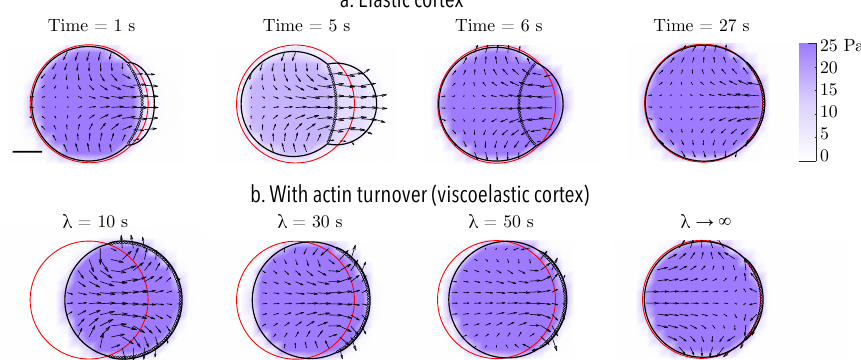
Figure 5. Reciprocity of bleb-based motion for an elastic and a viscoelastic actomyosin cortex with actin turnover timescale λ . ( a ) In the absence of confinement, the motion of bleb expansion and retraction over one cycle (approximately 7 s) and at a time value after 4 bleb cycles (27 s) is (nearly) reciprocal. ( b ) Cell position after 4 bleb cycles (27 s) for a cell with viscoelastic cortex with different strain relaxation timescales λ . Across all panels, the initial bleb neck size is 16 µ m. The initial position of the membrane is shown in red. The current position of the membrane is shown in black, and the position of the old cortex are denoted with black circles. The vector field represents the intracellular fluid velocity, and the scalar color field represents cytosolic